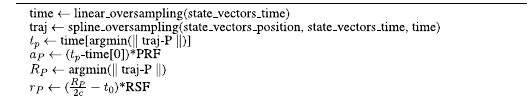
corresponds to the distance of the GCP to the Earth center. The direction and the sampling of the grid axes correspond to the azimuth and the range axes of the main image, as sketched in Figure 1.